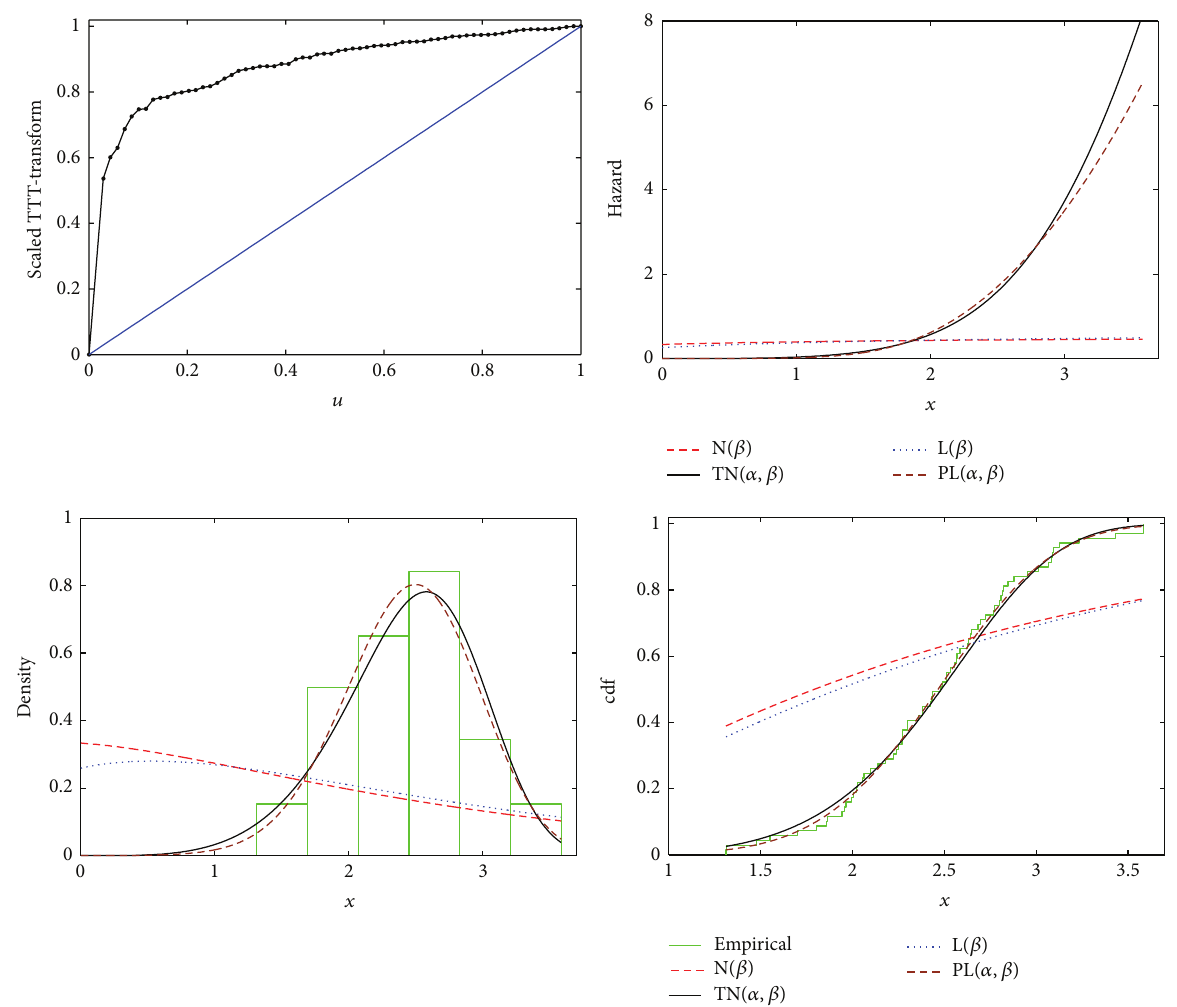
Figure 11: The TTT-transform, hazard, pdf, and cdf of the tensile strength data.